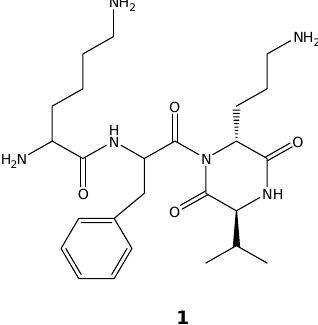
Figure 1. Structure of cyclo[ N -(Lys-Phe)-Orn-Val] ( 1 ).